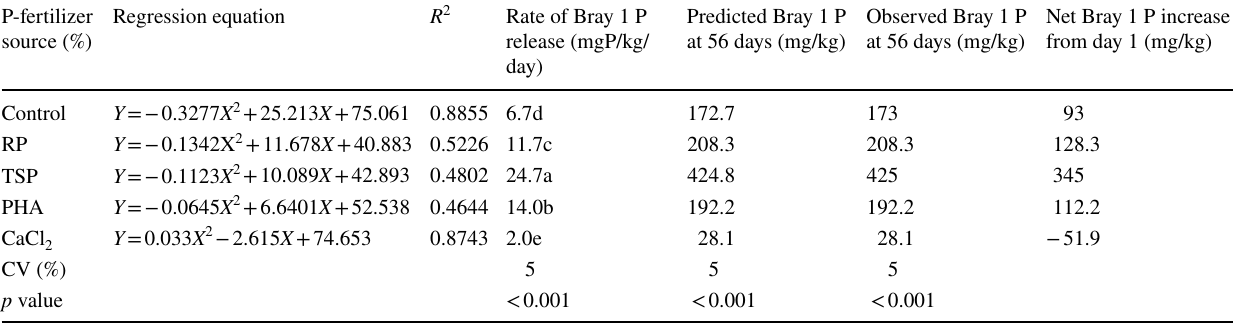
Table 3 Relationship between different P-fertilizer source and Bray P extractable during vermicomposting of cow dung–waste paper mixtures mixed with rock phosphate